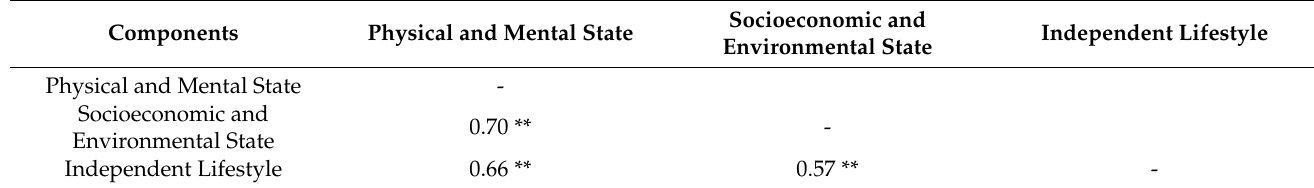
Table 5. Component correlation matrix of 3 factors.